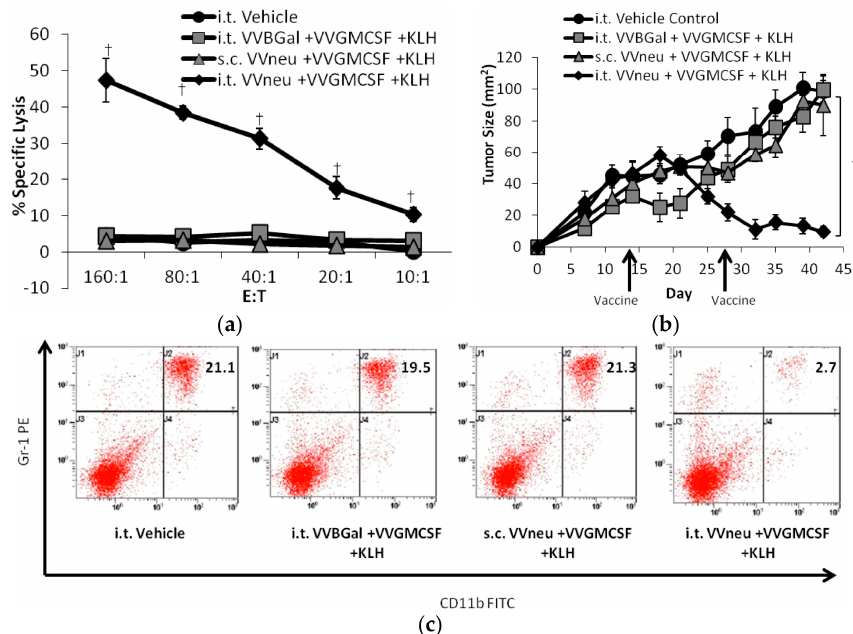
Figure 3. Vaccination into the tumor microenvironment with recombinant VV-neu leads to tumor regression, increased systemic CTL response, and reverses the systemic elevation in MDSC. ( a ) In a mouse HER2+ breast cancer mode, vaccination into the tumor microenvironment with recombinant vaccinia expressing the HER2/neu TAA (i.t. VV-neu + VV-GMCSF + KLH) results in a tumor specific CTL response; ( b ) regression of the primary tumor; ( c ) and a decrease in systemic MDSCs, whereas systemic treatment (s.c. VV-neu + VV-GMCSF + KHL) is not effective. Reprinted from [91], with permission from Elsevier.